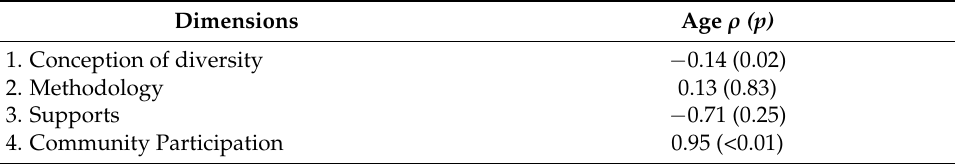
Table 5. Correlations between the dimensions and the age group